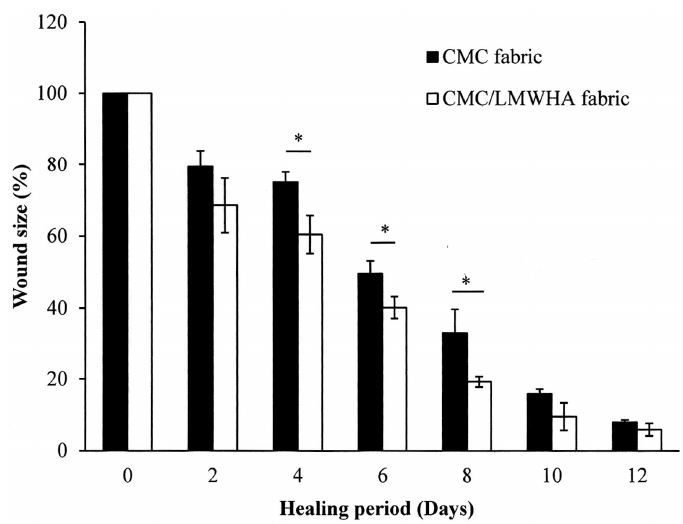
Figure 8. Photographs of the wound in rats after skin excision on days 0, 2, 4, 8 and 12.